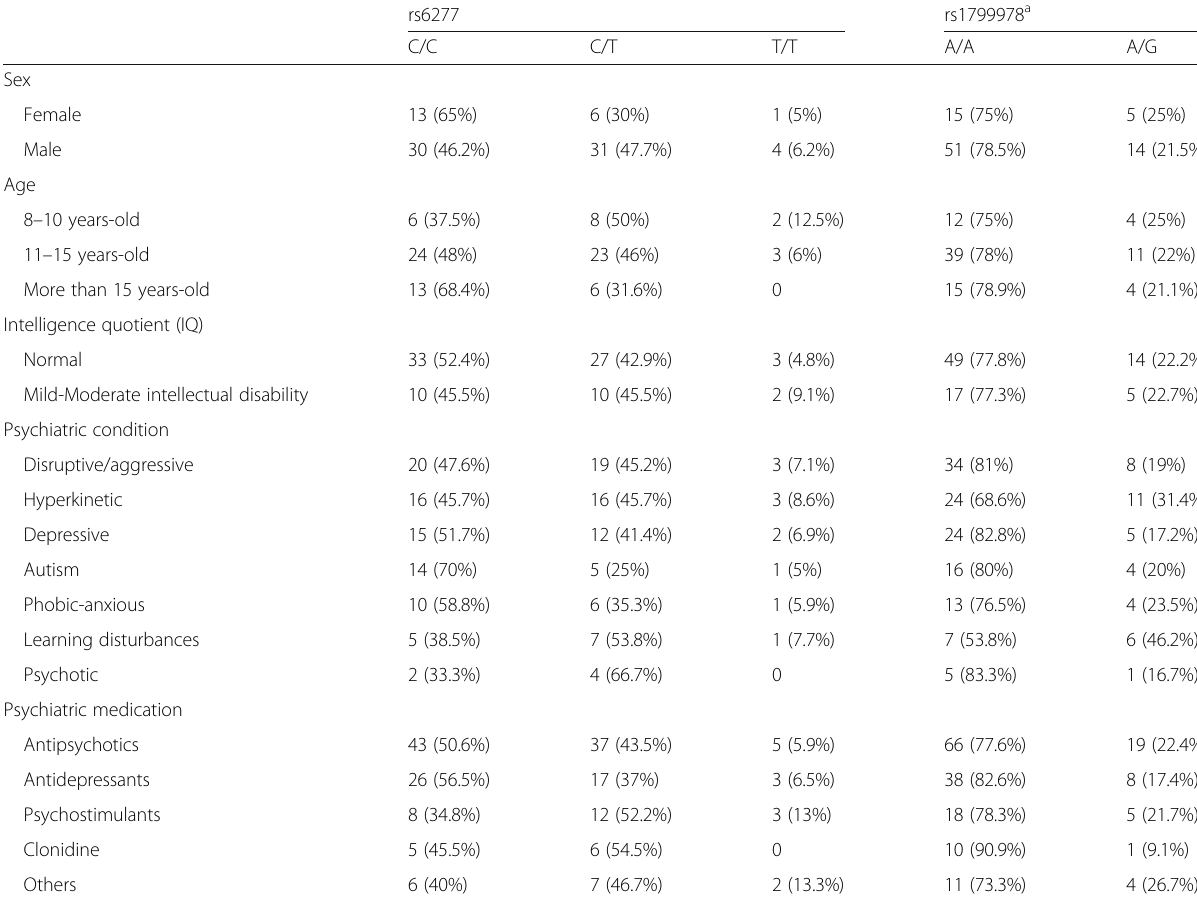
Table 2 Genotypic distribution of the evaluated SNPs of the DRD2 gene, regarding demographic data, psychiatric diagnoses and use of psychopharmacological medications